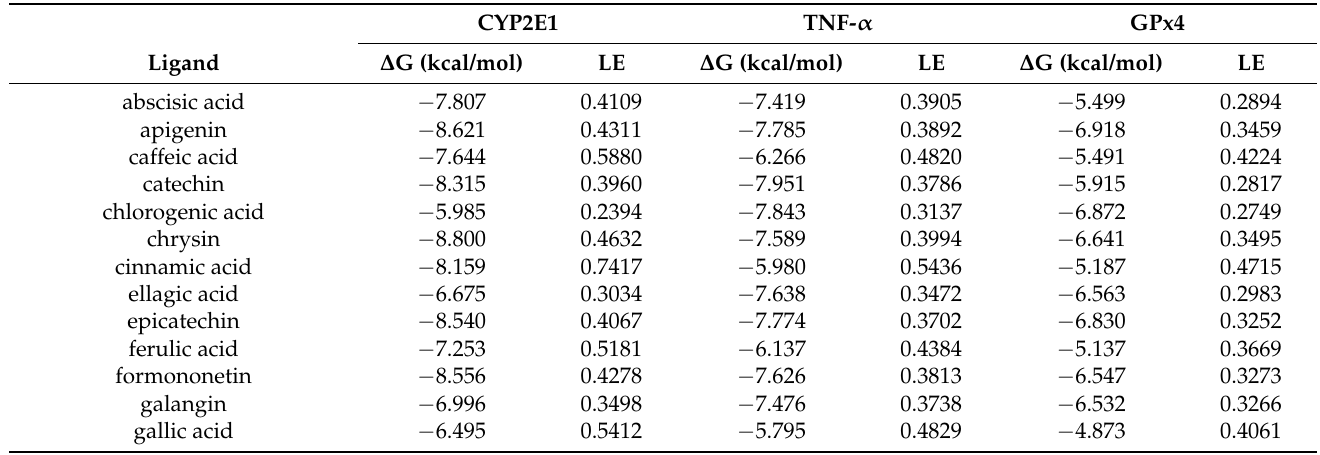
Table 16. Predicted binding energies and calculated ligand efficiencies for screened polyphenolic compounds on 3 target proteins relevant for potential hepatoprotective